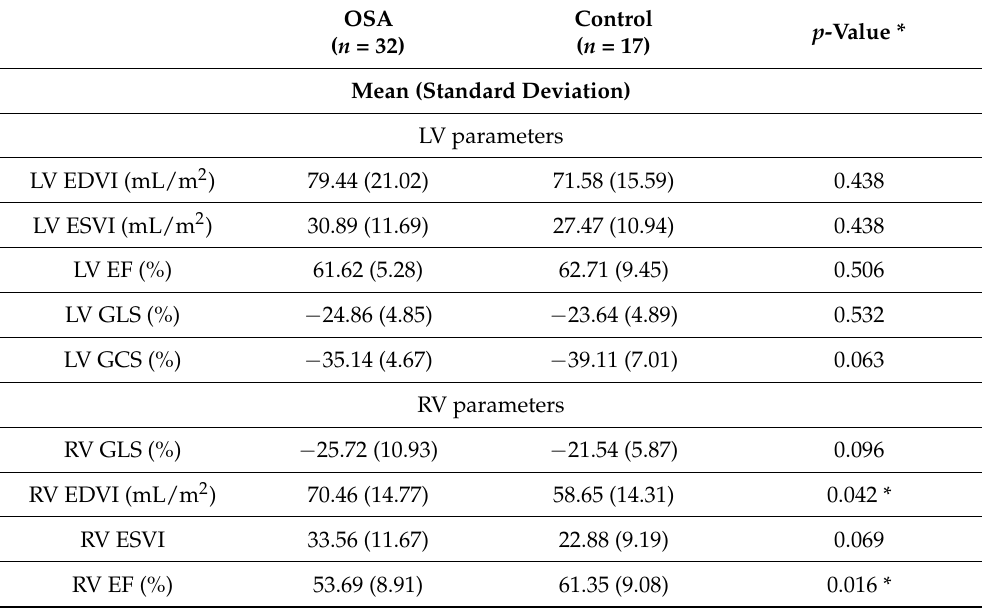
Table 4. Cardiac MRI parameters of control and OSA group patients.